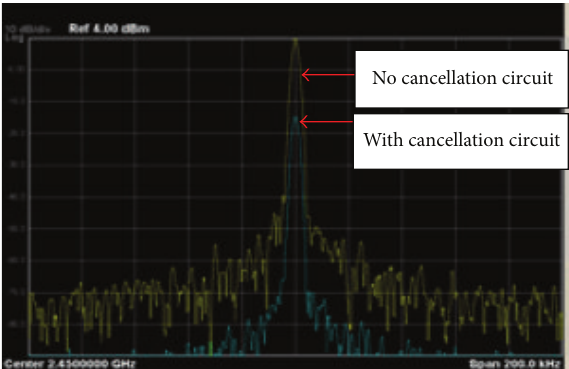
Figure 6: Comparison results after adding cancellation circuit.